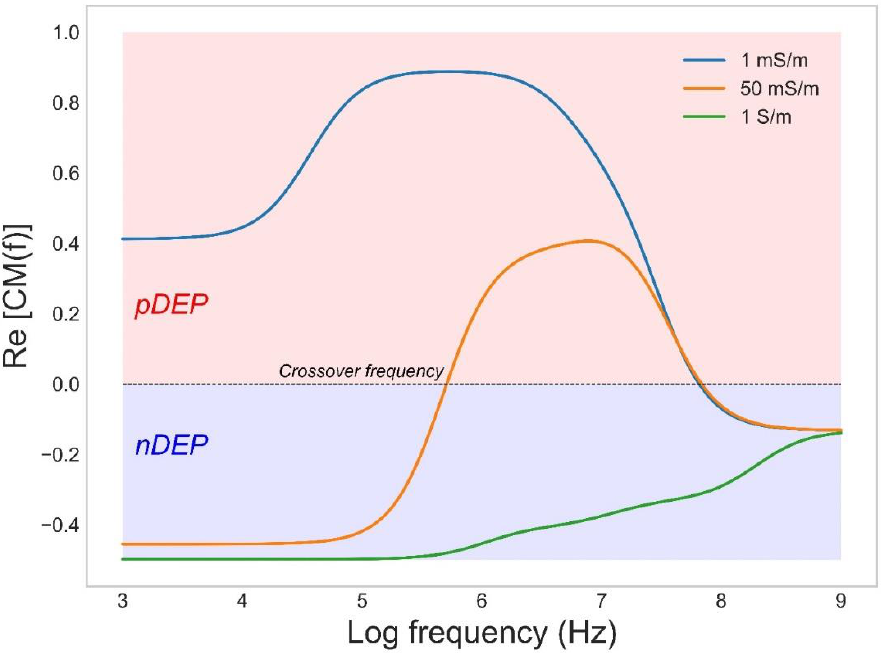
Figure 1. The CM factor as a function applied frequency for the bacterium Escherichia coli in medium with conductivities of 1, 50, and 1000 mS/m.